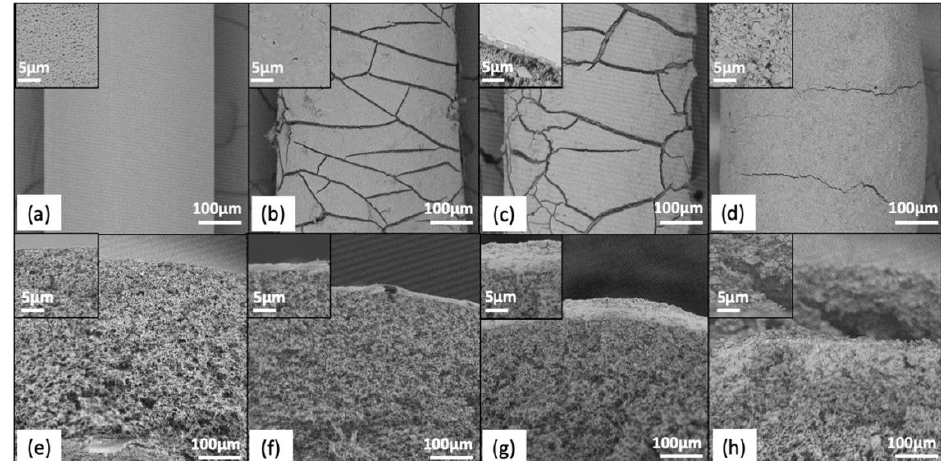
Figure 2. SEM images of fouling development on F2 for control modules (nonbackwashed) by influent water. Outer membrane surface at 500× and 15,000× (insets) for control: ( a ) clean fiber, ( b ) Bacteria, ( c ) BacChem, and ( d ) BacSed. Cross-section showing fouling layer thickness on the outer surface (2500× and 10,000× (insets)) for ( e ) clean fiber, ( f ) Bacteria, ( g ) BacChem, and ( h ) BacSed.